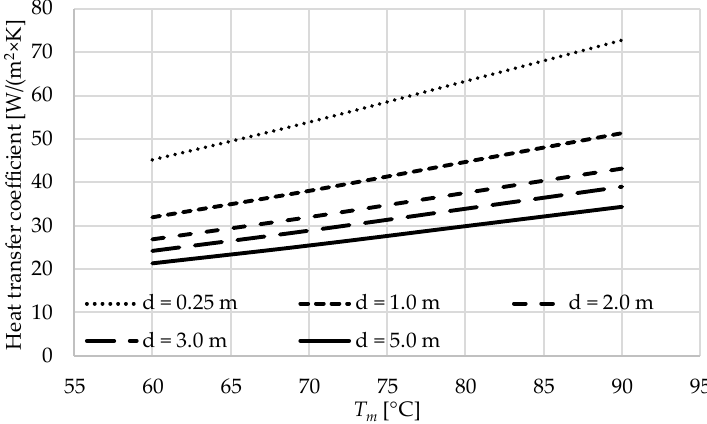
Figure 15. Values of the heat transfer coefficient α depending on the characteristic dimension of the layer (width - d ) and precipitation rate of 3l/m 2 /h